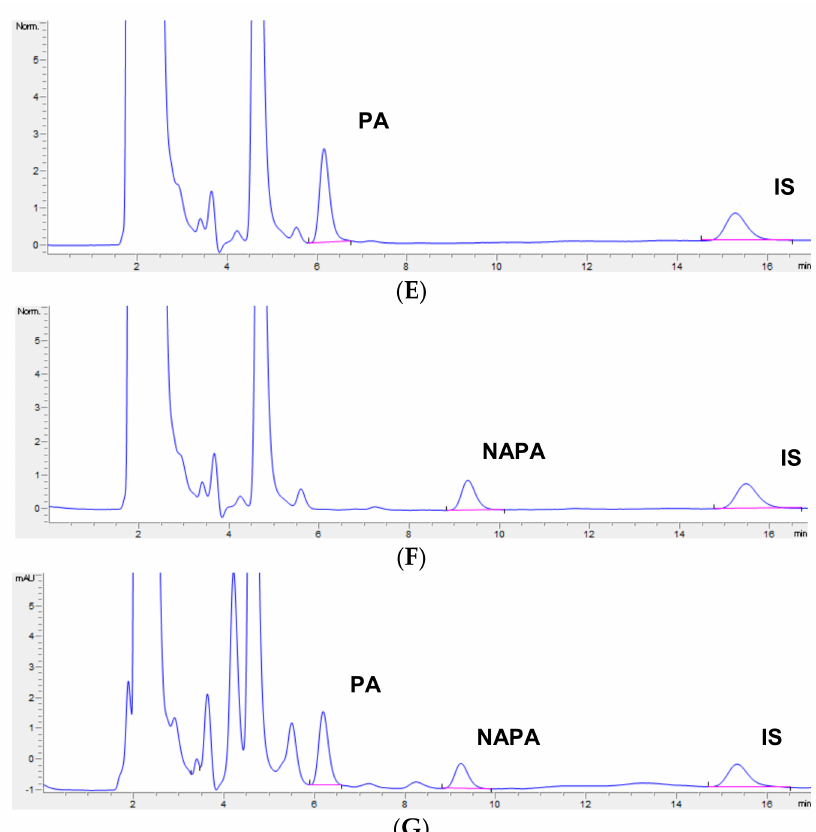
Figure 2. Chromatograms of ( A ) blank rat plasma; ( B ) plasma spiked with IS (200 ng/mL); ( C ) plasma spiked with procainamide (20 ng/mL, lower limit of quantification (LLOQ)) and IS (200 ng/mL); ( D ) plasma spiked with N -acetylprocainamide (20 ng/mL, LLOQ) and IS (200 ng/mL); ( E ) plasma spiked with procainamide (1000 ng/mL) and IS (200 ng/mL); ( F ) plasma spiked with N -acetylprocainamide (500 ng/mL) and IS (200 ng/mL) and ( G ) 30 min after intravenous administration of procainamide hydrochloride (10 mg/kg). PA: procainamide, NAPA: N-acetylprocaiamide, IS: internal